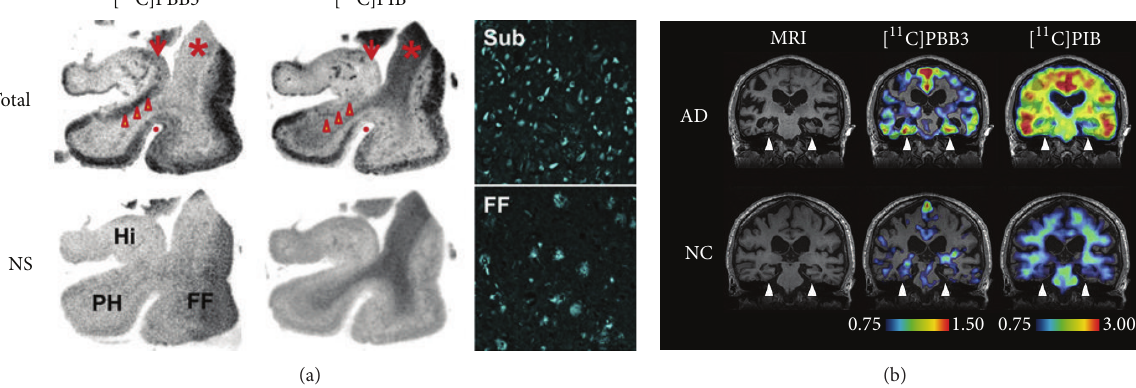
Figure 5: Accumulation of [ 11 C]PBB3 in the hippocampal formation of AD patients revealed by in vitro autoradiography (a) and in vivo PET (b). Reproduced from [28] with permission, copyright 2014